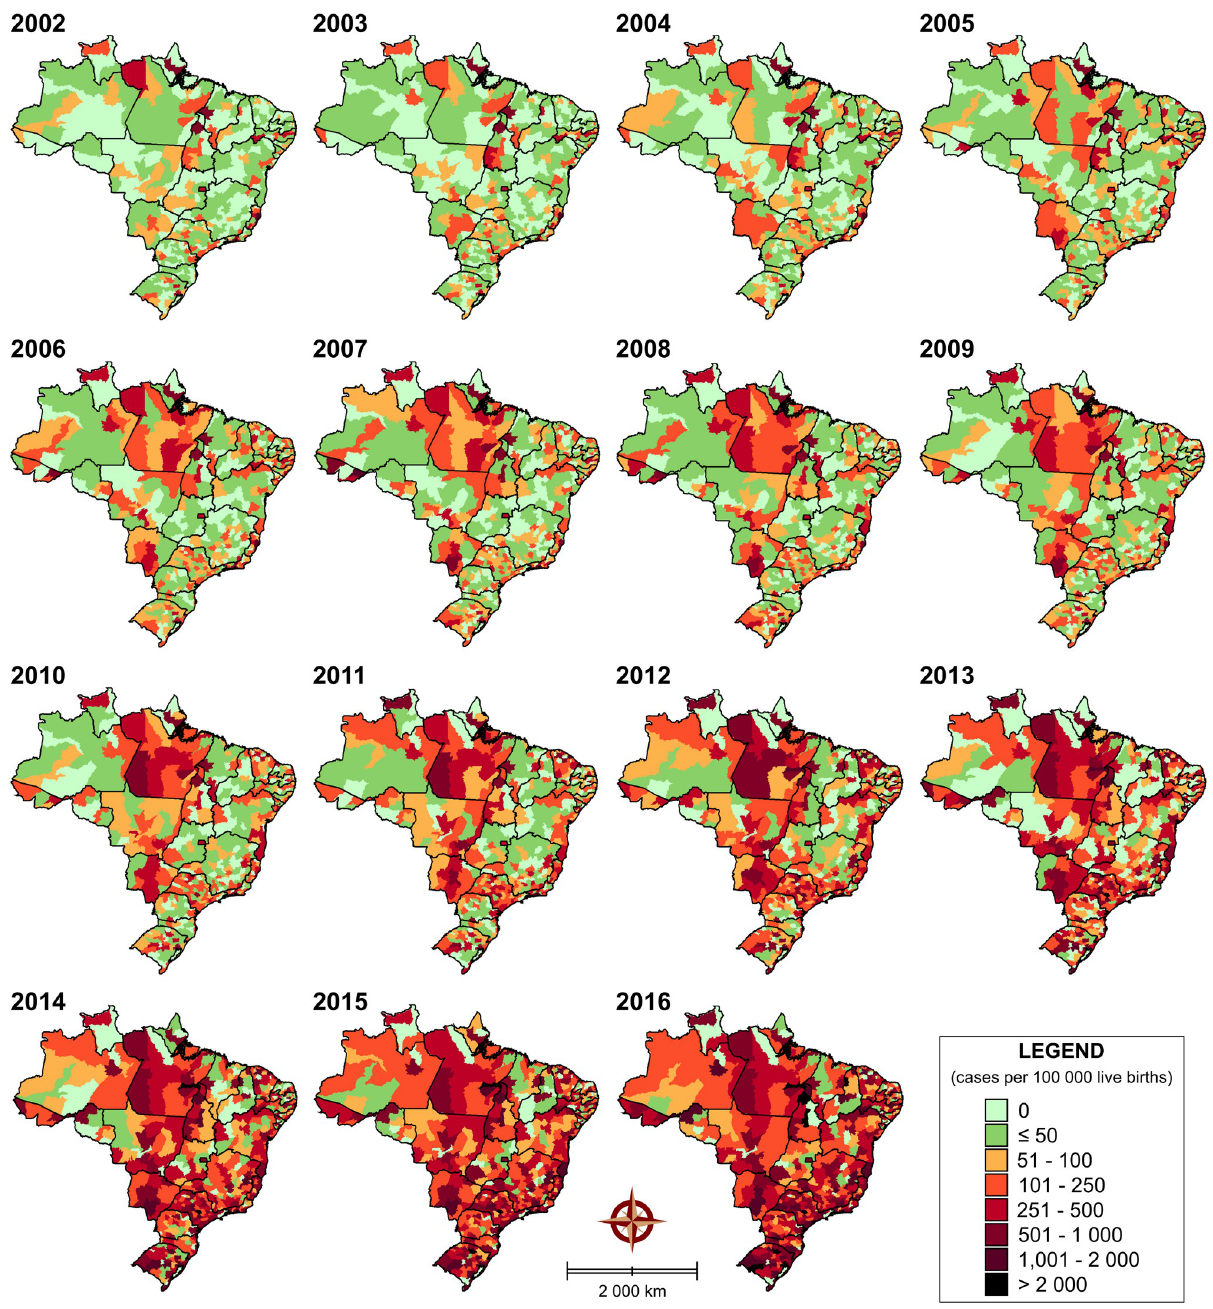
Fig 5. Spatiotemporal distribution of CS cases (2002 to 2016) in Brazil, based on cases by microregions. Digital maps in the public domain (publicly available) were obtained from IBGE cartographic database in shapefile format (.shp), which was subsequently reformatted and analyzed using QGIS version 3.10. Authors specify that this figure is licensed under CC BY